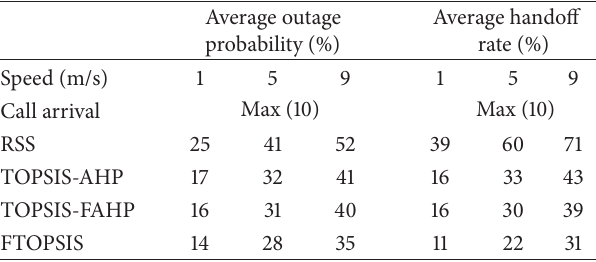
Table 8: VHONE for conversational